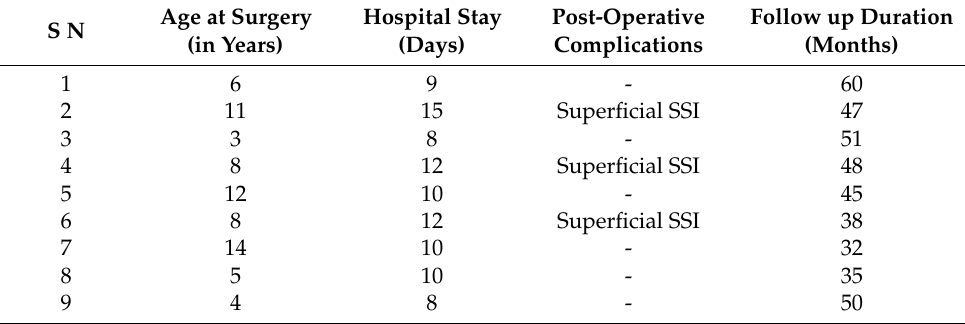
Table 1. Patient Characteristics.